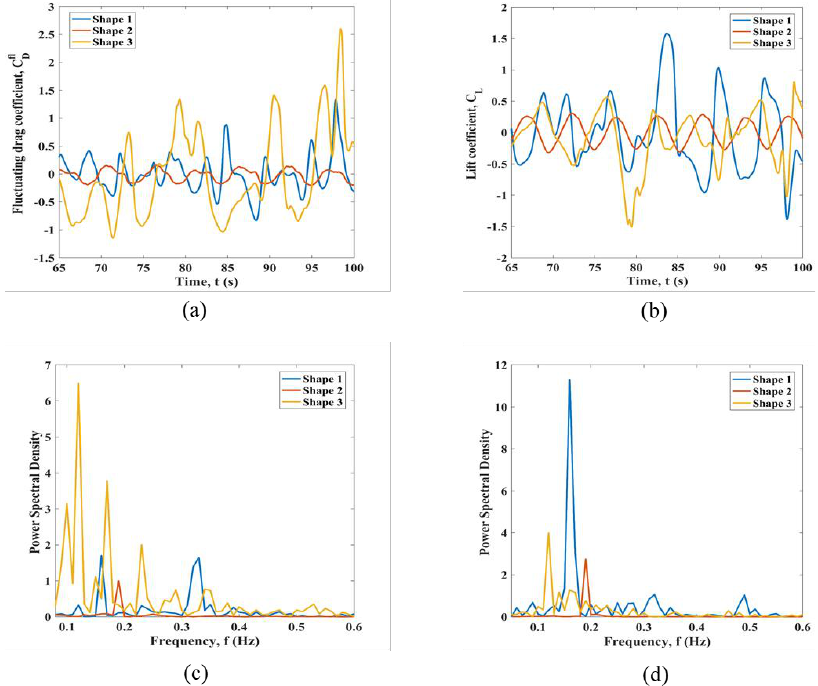
Figure A17. Fluid force coefficients for cylinder 3 immersed in planar sheared flow: ( a ) time history of the fluctuating drag coefficient; ( b ) time history of the lift coefficient; ( c ) the fluctuating drag co–efficient FFT; ( d ) the lift coefficient FFT.